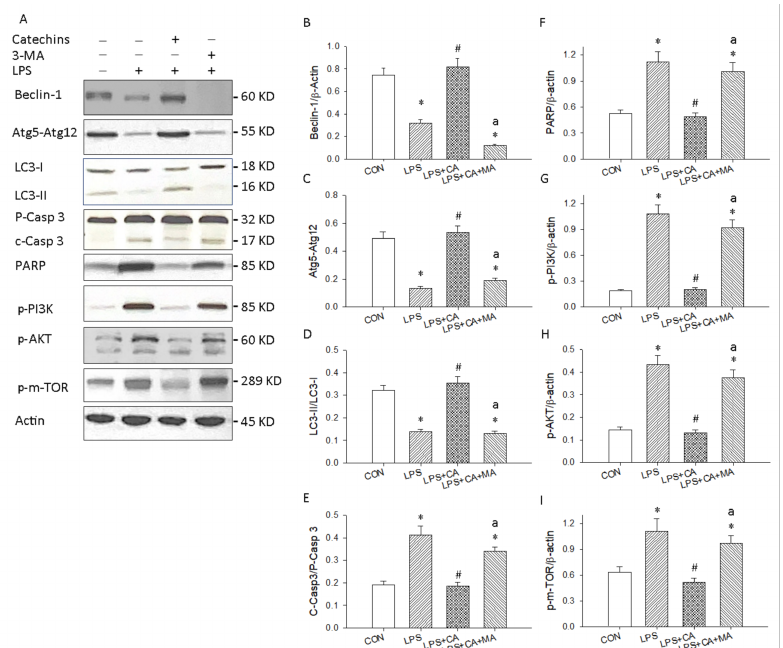
Figure 9. Catechins promoted autophagy dependent protective mechanism against ALI. ( A ) Western blotting detected the levels of autophagy related Beclin-1, Atg5-Atg12 and LC3-II/I, apoptosis related proenzyme and cleavage Caspase 3 and PARP and the PI3K/AKT/m-TOR signaling in lung tissues. Quantitative analysis of autophagy related Beclin-1 ( B ), Atg5-Atg12 ( C ), and LC3-II/I ( D ); apoptosis related C-Casp3/P-Casp3 ( E ); and PARP ( F ), p-PI3K ( G ), p-AKT ( H ), and p-m-TOR ( I ) are displayed in bar graphs, respectively. These experiments were performed three independent times ( n = 3), and bars represented as mean ± SEM; * p < 0.05 vs. CON group; # p < 0.05 vs. LPS group; a p < 0.05 vs. LPS + CA